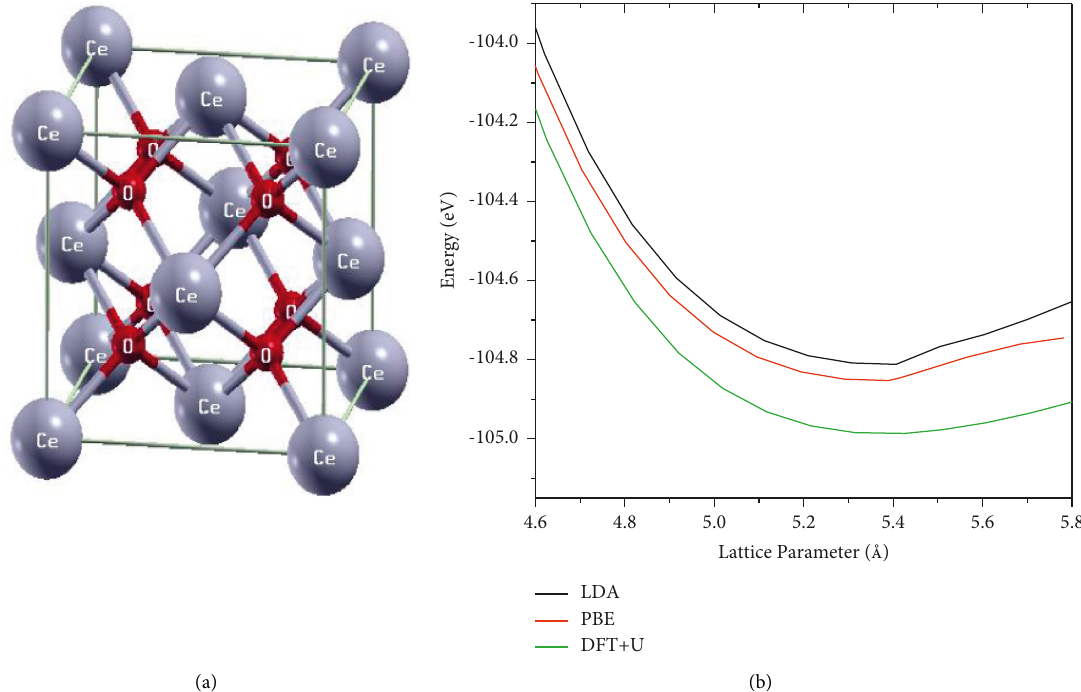
Figure 1: (a) Bulk structure of ceria and (b) lattice parameter of ceria in LDA, PBE, and DFT + U